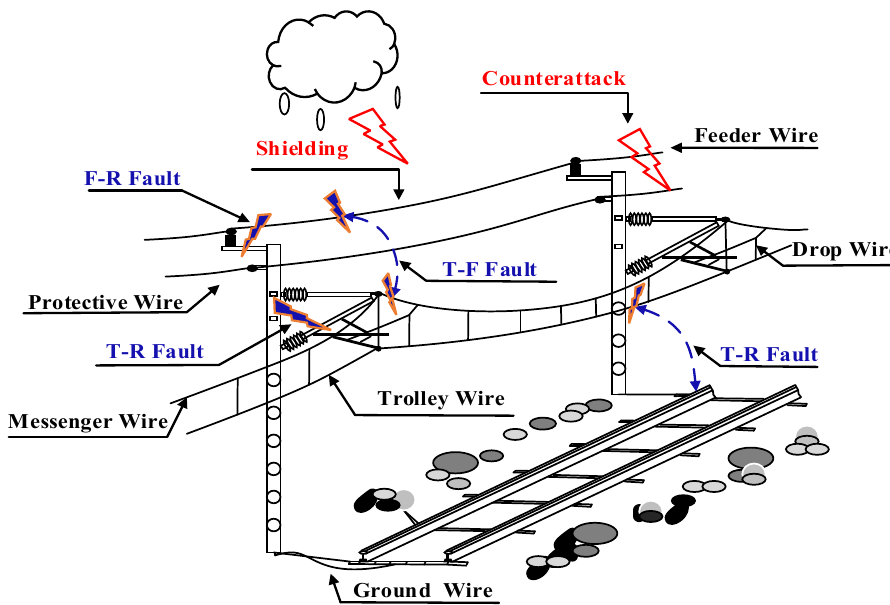
Figure 1. Structure configuration of the AT traction Network.